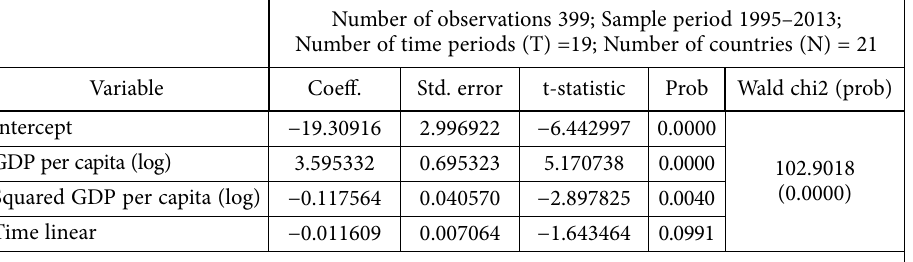
Table 2. Random effect GLS regression Dependent variable: logarithm of Environmental protection expenditure by central